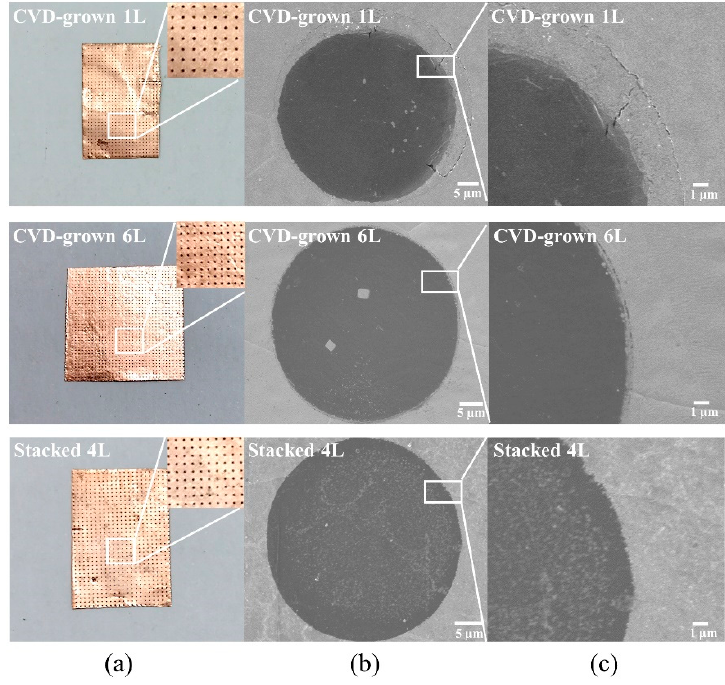
Figure 1. ( a ) Optical images of suspended graphene array with CVD-grown 1L, CVD-grown 6L, and stacked 4L. ( b ) SEM images of suspended graphene film with a diameter of 50 µ m for CVD-grown 1L, CVD-grown 6L, and stacked 4L, respectively. ( c ) SEM images in larger magnification show the detailed edges of suspended graphene fi lm.